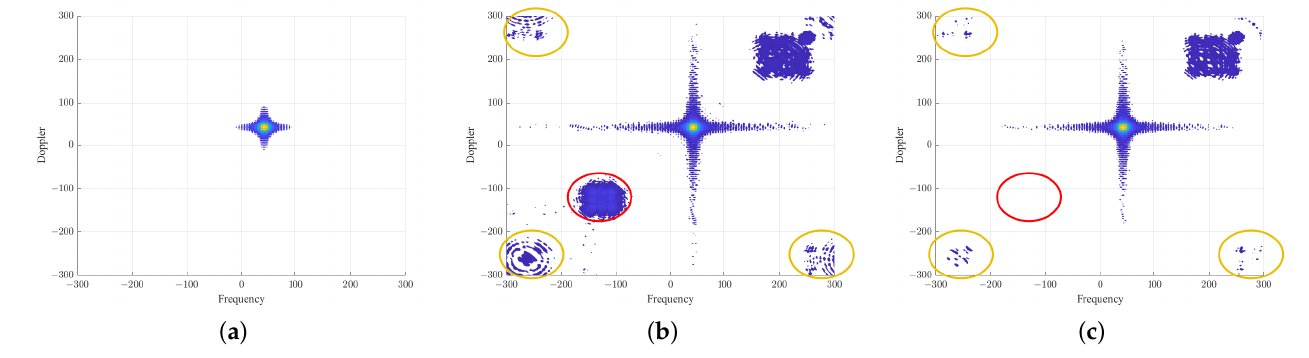
Figure 7. The two-dimensional spectrum of a wideband signal with a high oversampling rate set to 20. ( a ) Results with high-precision quantization. ( b ) Results with one-bit quantization. ( c ) Results with the proposed two-bit quantization.